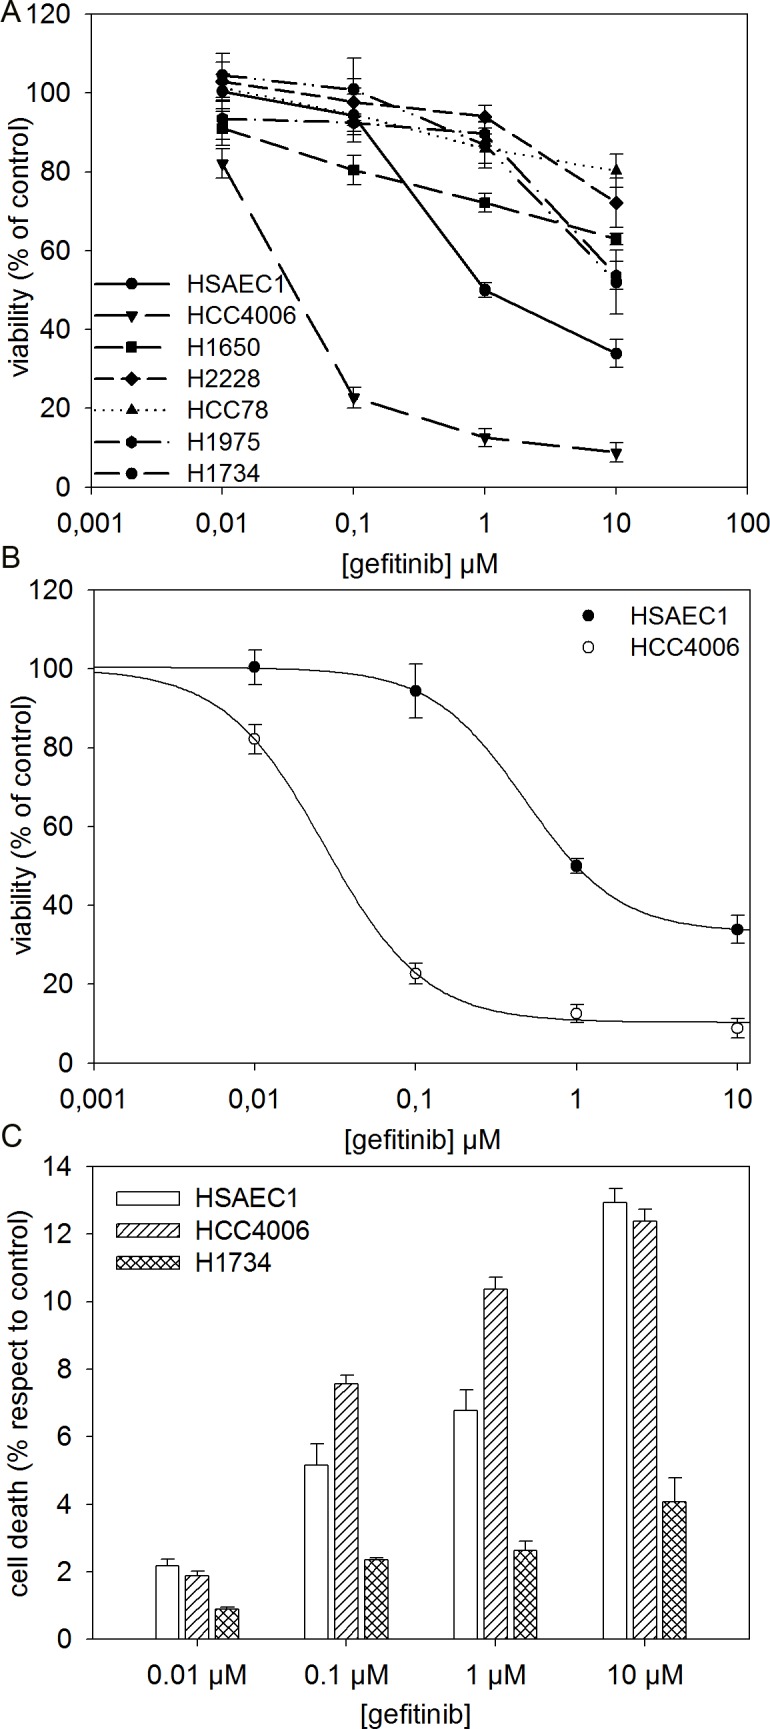
Sensitivity to gefitinib.(A) Dose-response curves of human lung cell lines to gefitinib. Cell survival was determined by MTT assay in the absence or the presence of different gefitinib doses (0, 0.01, 0.1, 1 and 10 μM) for 72 h. Viabilities are expressed as a percentage of the untreated control ± standard error (SE). (B) Nonlinear Regression of experimental data for HSAEC1 and HCC4006 cells lines was obtained using a Four Parameter Logistic Curve f1 = min + (max-min)/(1 + (x/EC50)^(-Hillslope)). (C) Cell death of HSAEC1, HCC4006 and H1734 cells lines was determined by flow cytometry through PI staining. The cells were treated with different gefitinib concentration ranging from 0.01 to 10 μM for 72 h and stained by PI dye. The zero concentration was defined as a control and cell death was expressed as a percentage of the control ± standard error (SE).